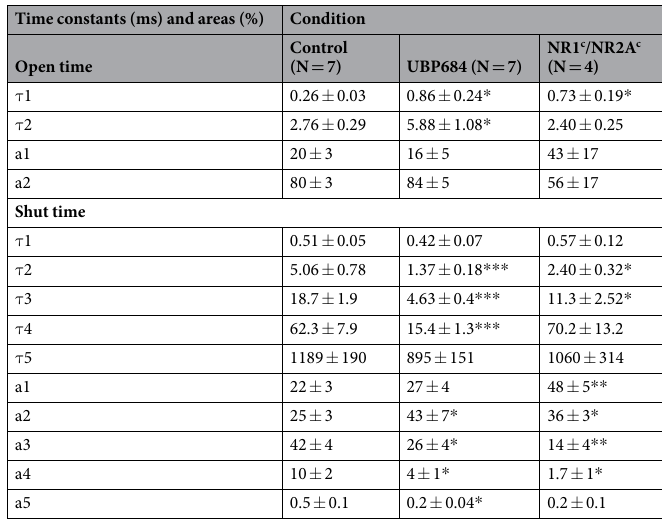
Table 1. Time constants and area of the open and shut time histogram fits with Hidden Markov models. The histograms were fitted with a model containing 5 closed states and 2 open states. Mean ± SEM are presented. Comparison was performed using unpaired t -test in relation to control. * P < 0.05, ** P < 0.01 and *** P <